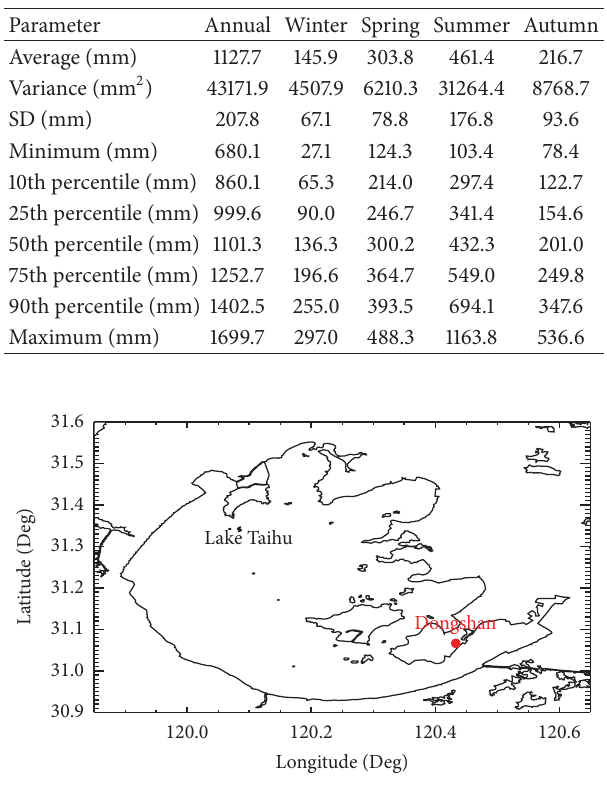
Figure 1: Location of the Dongshan weather